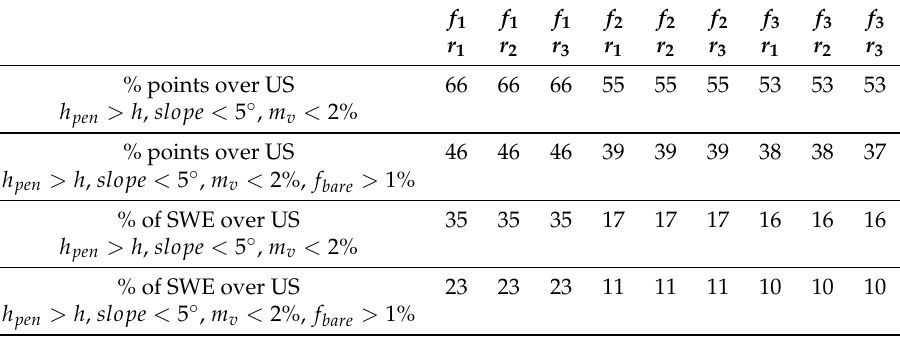
Table 1. US data satisfying the precondition of the dual polarization dual frequency (dual-pol. dual-freq.) retrieval method in 1997, ( f 1 = 1 GHz, f 2 = 13.5 GHz, f 3 = 17.25 GHz , r 1 = 0.2 mm, r 2 = 0.5 mm, r 3 = 0.8 mm).